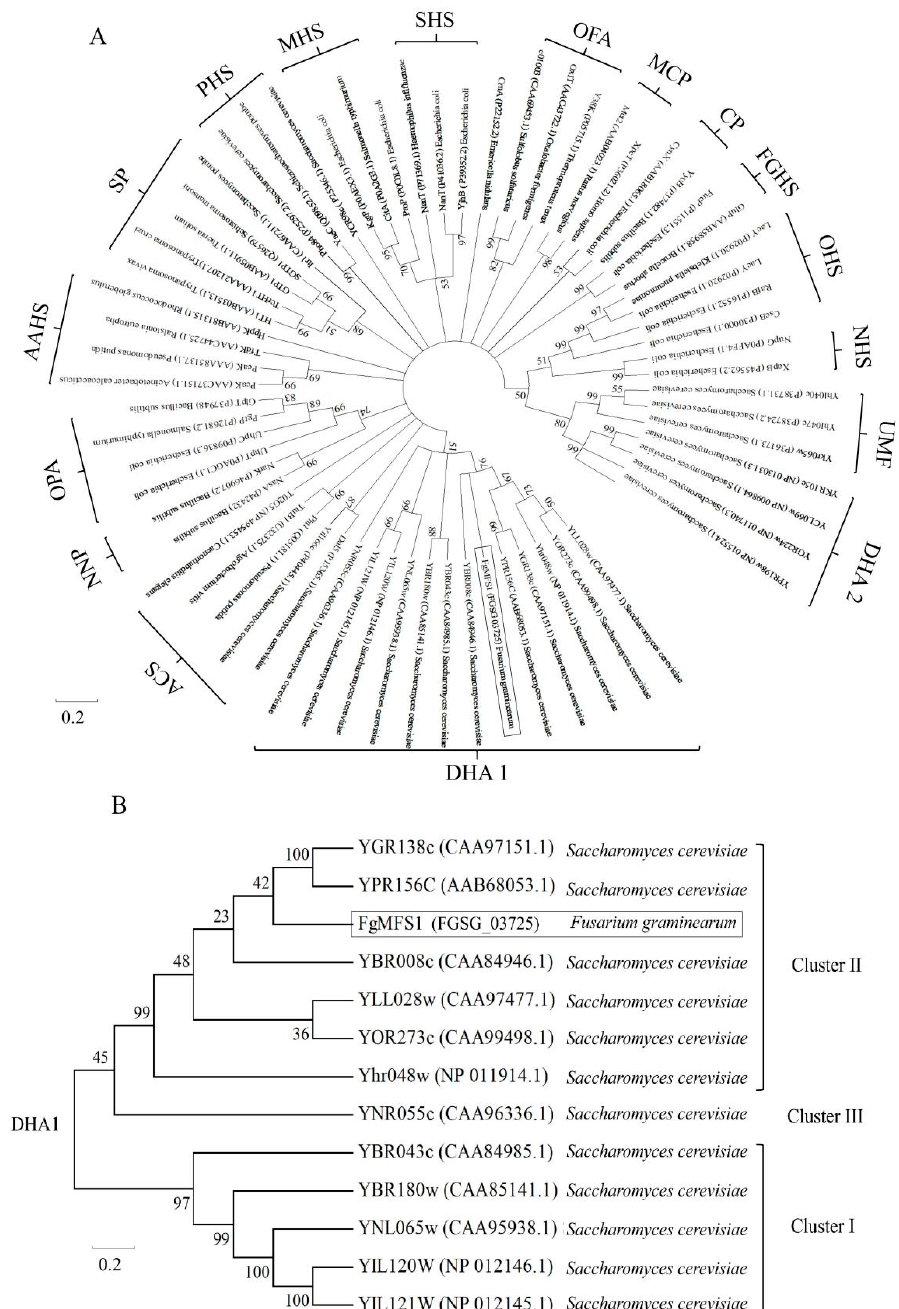
Figure 3. Phylogenetic analysis of MFS transporters. ( A ) MFS transporters can be classified into 17 families: DHA 1 (drug: H + antiporter (12-TMS)) drug efflux family, ACS (anion: cation symporter) family, NNP (nitrate–nitrite porter) family, OPA (organophosphate: inorganic phosphate antiporter) family, AAHS (aromatic acid: H + symporter) family, SP (sugar porter) family, PHS (phosphate: H + symporter) family, MHS (metabolite: H + symporter) family, SHS (sialate: H + symporter) family, OFA (oxalate: formate antiporter) family, MCP (monocarboxylate porter) family, CP (cyanate permease) family, FGHS (fucose–galactose–glucose: H + symporter) family, OHS (oligosaccharide: H + symporter) family, NHS (nucleoside: H + symporte) family, UMF (unknown major facilitator) family, and DHA 2 (drug: H + antiporter (14-TMS)) drug efflux family. ( B ) Phylogenetic analysis of the members of DHA1 family. “YGR138c (CAA97151.1) Saccharomyces cerevisiae ” represents the protein name, accession number, and Latin name, respectively. The numbers under/above each node are the bootstrap